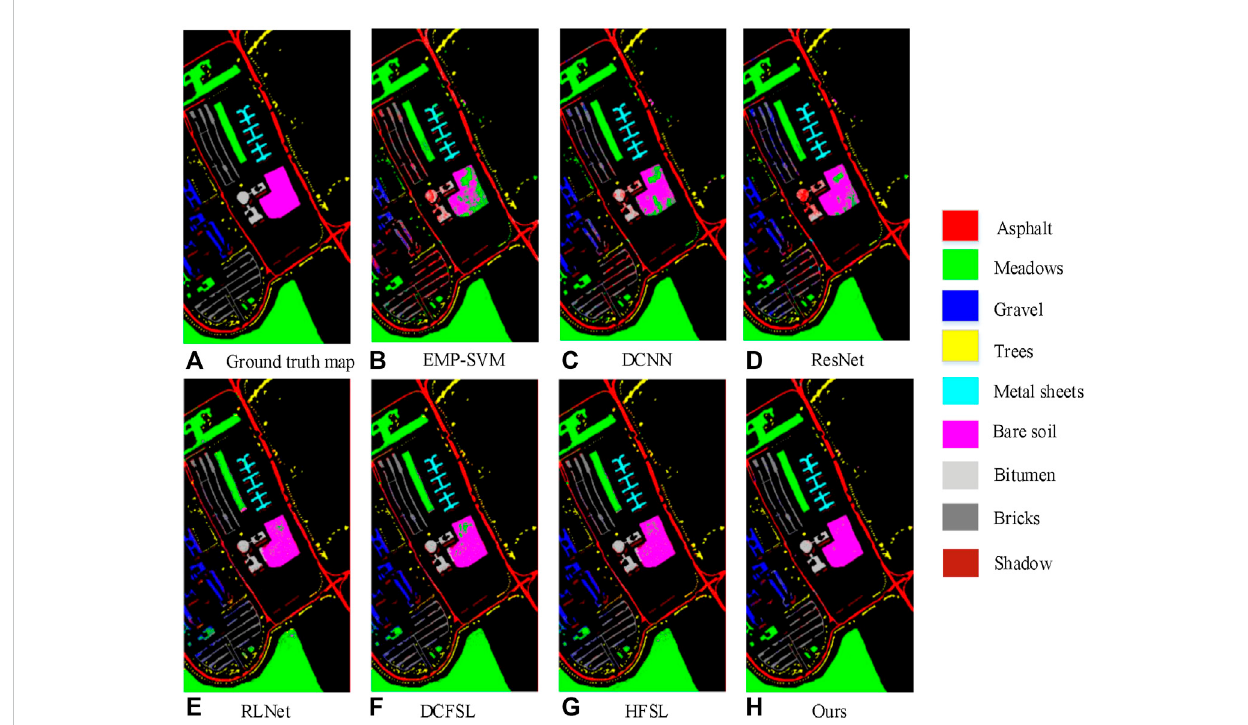
FIGURE 2 Classi fi cation maps of the Pavia University dataset. (A) ground truth; (B) EMP-SVM; (C) DCNN; (D) ResNet; (E) RLNet; (F) DCFSL; (G) HFSL; (H) Ours.